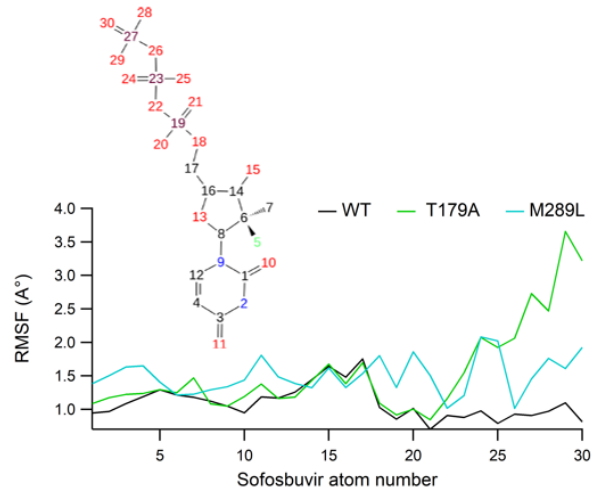
Figure 8. The RMSF values for atoms of GS-461203.